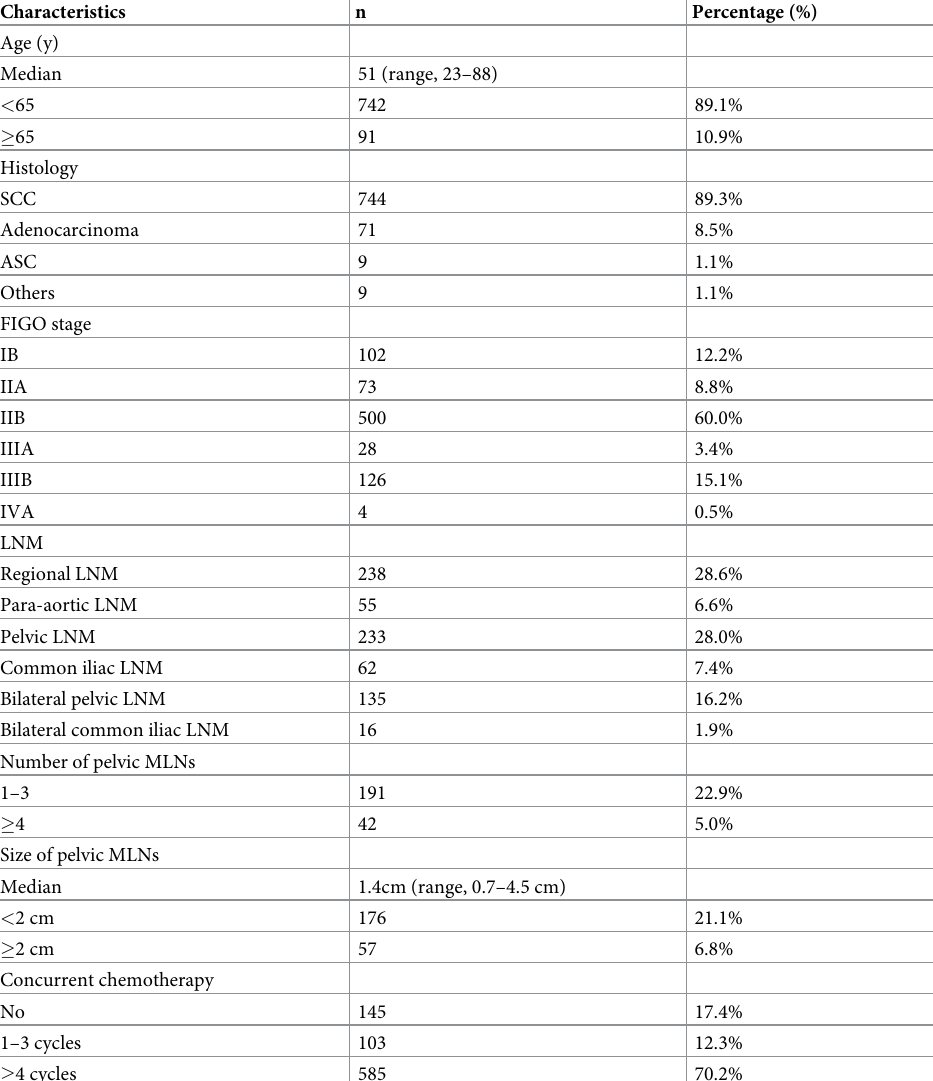
Table 1. The characteristics of the